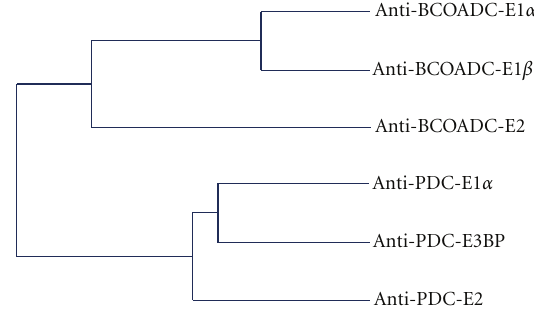
Figure 1: Interrelationships among antibodies against each sub- unit. Dendrogram was obtained by cluster analysis of the rela- tionships among the antibody reactivities in PBC sera against the individual antigenic subunits of BCOADC and PDC. The cluster analysis was conducted using the nearest neighbor method based on the Spearman correlation coe ffi cients in Table 2 as the similarity